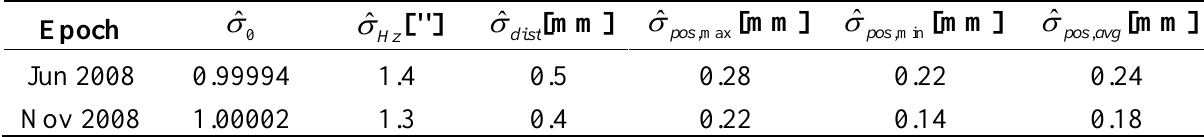
Table 4. Results of the adjustment using minimum datum parameters: a posteriori variances, precisions of the adjusted observations and positional precisions of the network